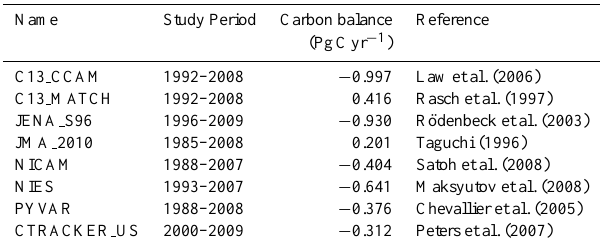
Table 2. Carbon balance derived by different atmospheric inverse models. Negative values indicate carbon